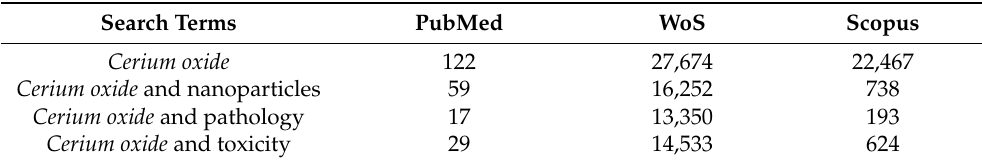
Table 1. Summary of the number of papers identified in searchers of different databases (PubMed, WoS and Scopus) using the search terms “cerium oxide OR ceria OR nanoceria OR nano ceria” from the years